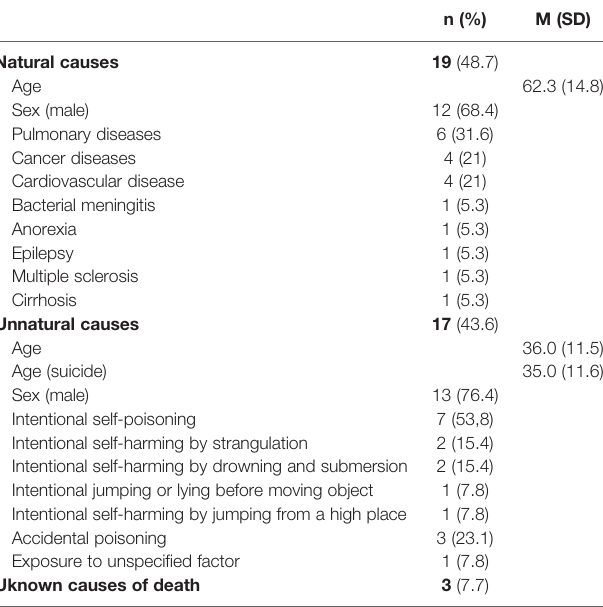
TABLE 6 | Causes of death in the cohort (n =